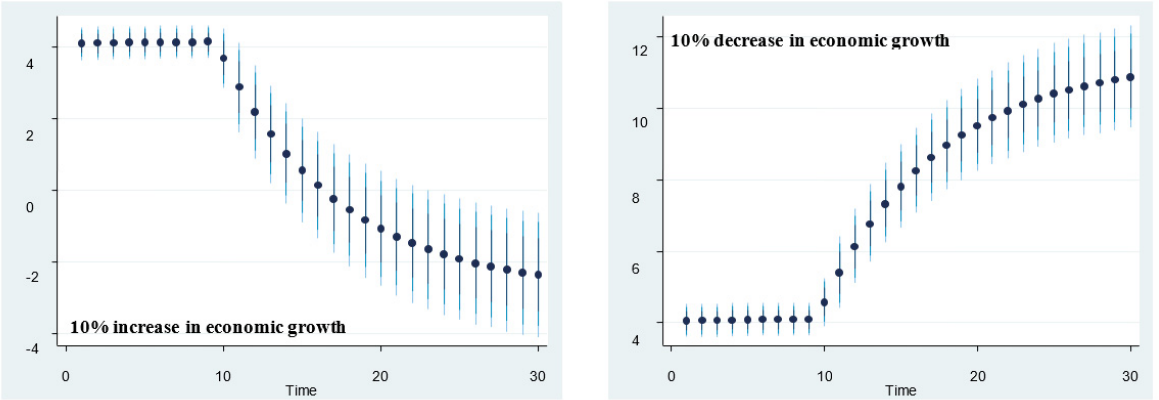
Figure 5. Economic growth and domestic investment. The above graphs portray ±10% in the economic growth and its impact on domestic investment. The dots depict the average prediction value, while the dark blue to light blue lines indicate 75%, 90%, and 95% confidence interval, respectively.